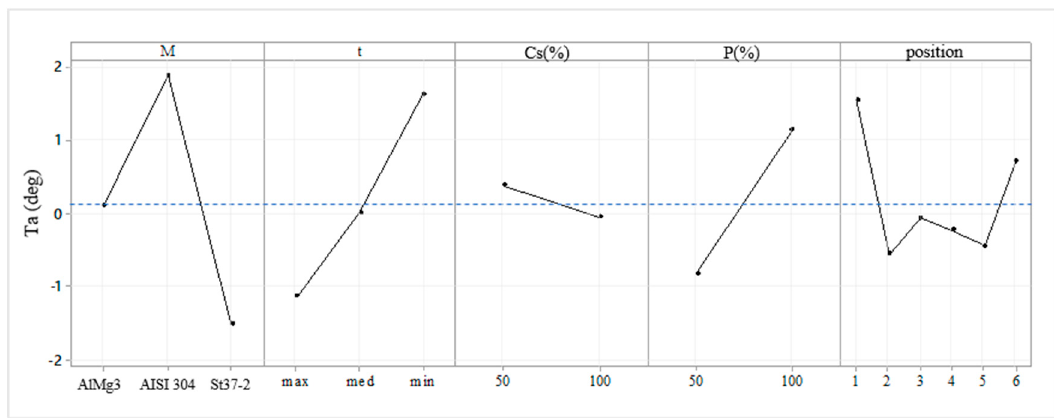
Figure 10. Main e ff ects plot for taper Figure 10. Main effects plot for taper angle.